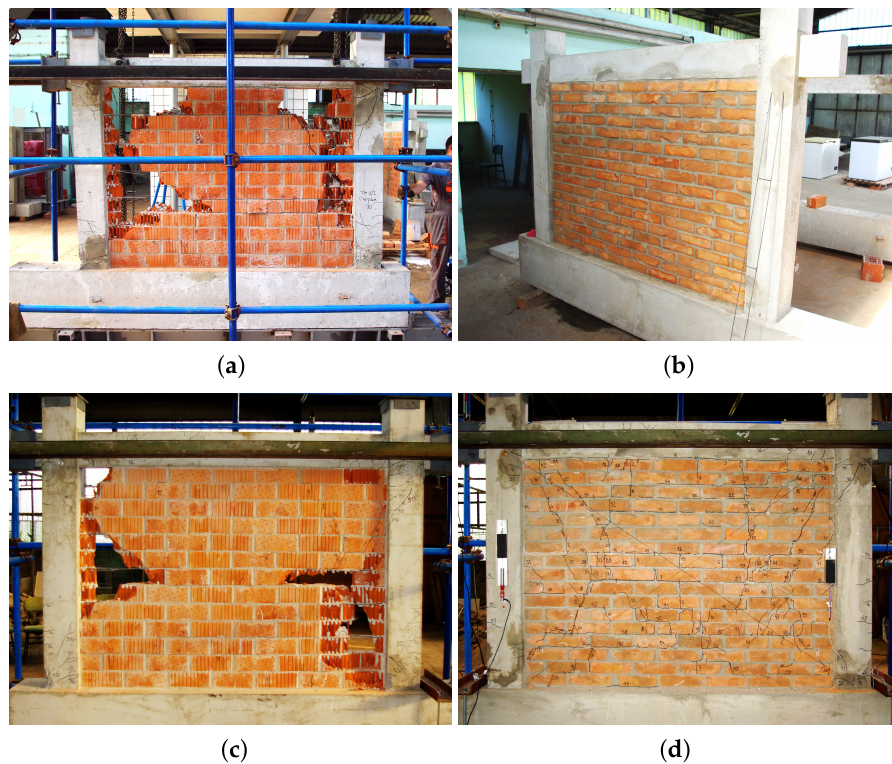
Figure 5. Photographs of the specimens during various phases: ( a ) specimen TYPE 1/I at 1.14% IDR (end of the experiment); ( b ) specimen TYPE 1/II before the experiment; ( c ) specimen TYPE 2/I at 1.50% IDR (the end of the experiment); and ( d ) the specimen TYPE 1/II at 1.18% IDR (the end of the